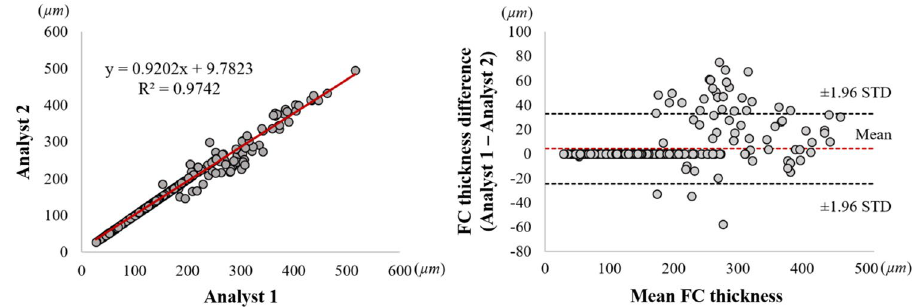
Figure 8. Inter-observer variability test of minimum fibrous cap thickness between two analysts after automated detection + manual editing. Panels are: (left) linear regression plot and (right) Bland–Altman plot. The R-squared ( R 2 ) value between two analysts was 0.974 (left), and the mean bias was 4.2 ± 14.6 µm (right). This result indicates that there is no significant bias between two experts for using software.